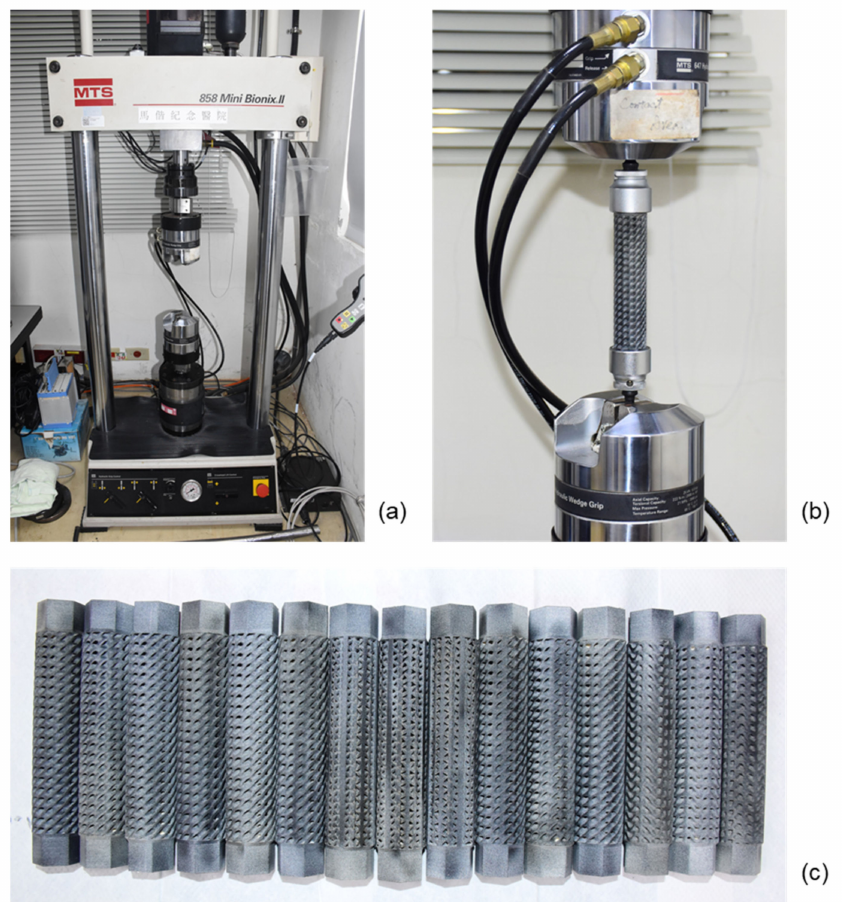
Figure 9. ( a ) Torsion testing machine, ( b ) Experimental setup and fitting of specimen in the machine, and ( c ) All three specimens for each lattice